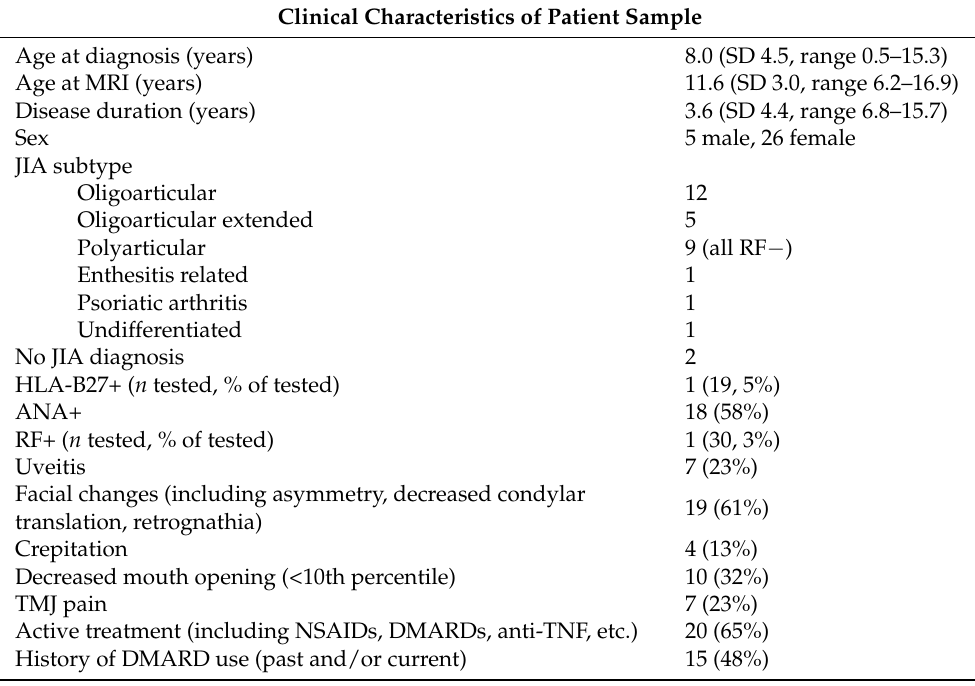
Table 1. Clinical characteristics of the cohort of 31 patients whose MRI examinations of temporo- mandibular joints (TMJs) were used for the reliability exercise. Laboratory and physical examination test values are those available at the closest date within three months in relation to the study MRI date. Abbreviations: JIA (juvenile idiopathic arthritis), SD (standard deviation), HLA-B27 (human leukocyte antigen B27), ANA (antinuclear antibody), RF (rheumatoid factor), DMARD (disease modifying antirheumatic drug), anti-TNF (tumor necrosis factor